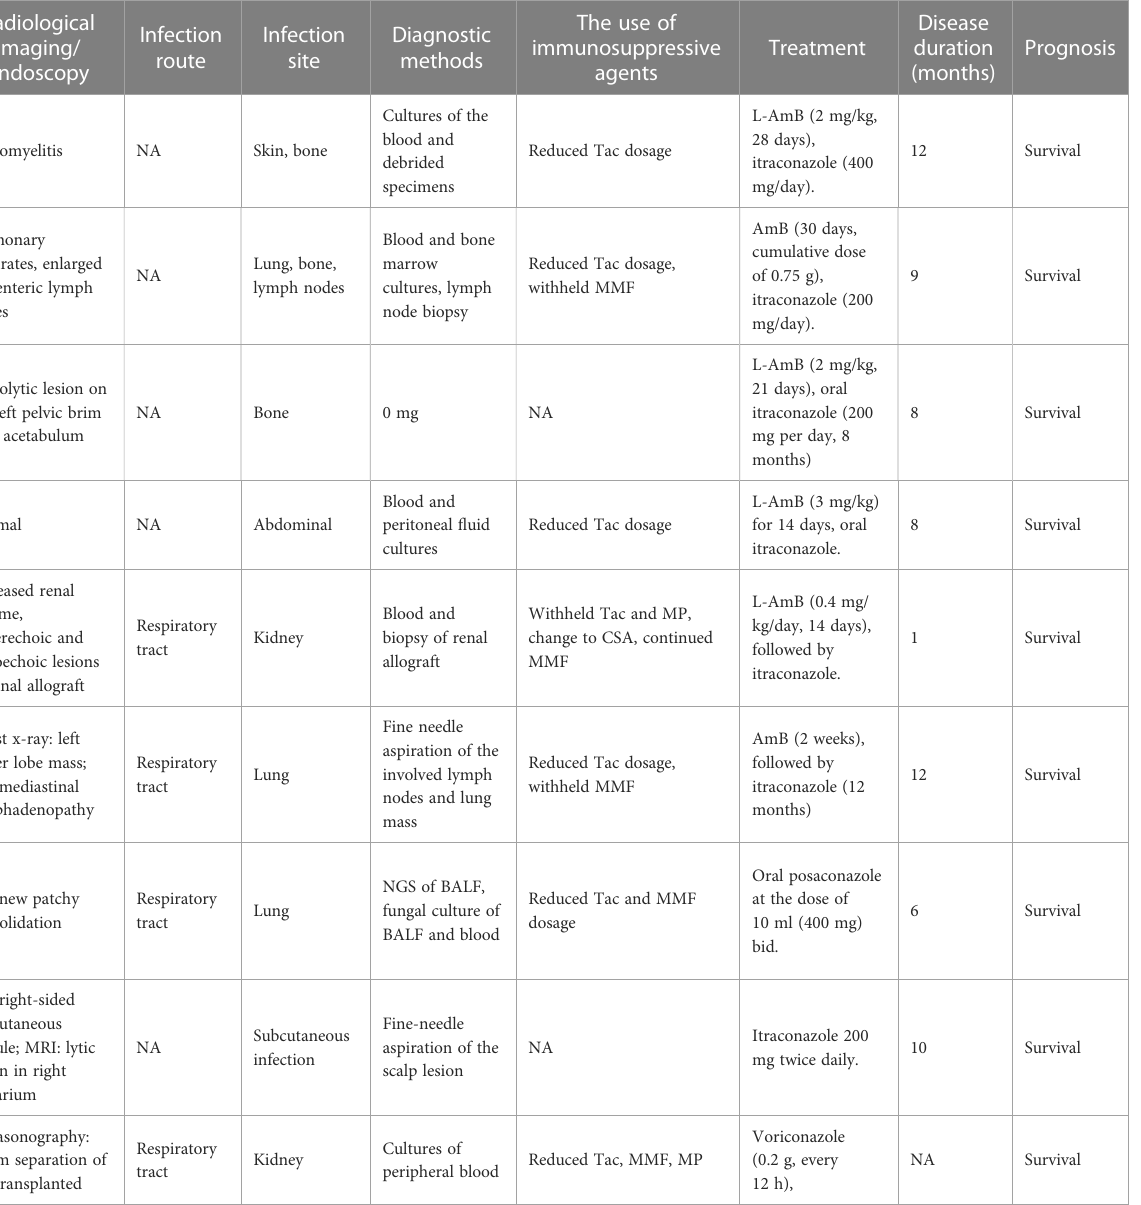
TABLE 1 Clinical information of Talaromyces marneffei infection after kidney transplantation.